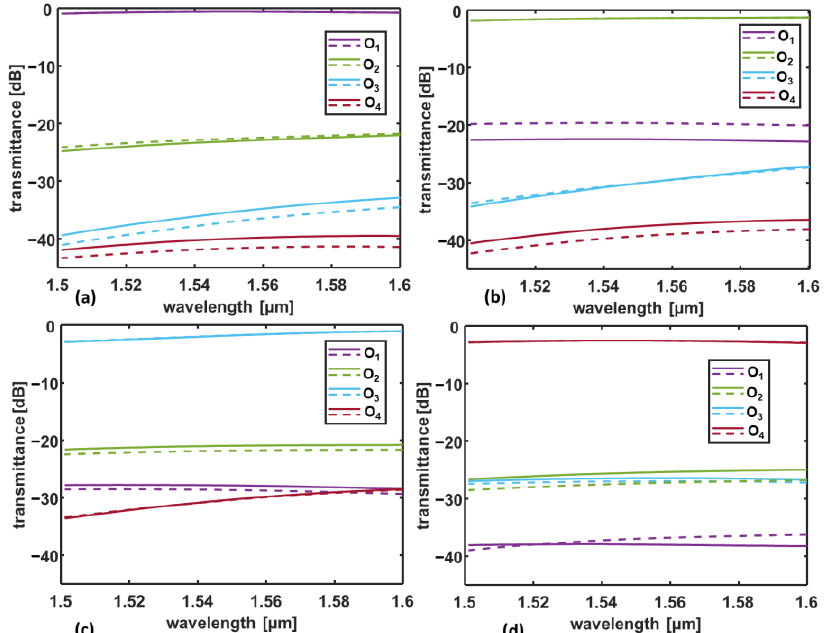
Figure 10. Transmittance in dB, calculated as a function of the wavelength, at the receiving OPAs, i.e., O 1 , O 2 , O 3 , and O 4 , when the transmitting OPA I 1 is excited with uniform (solid curves) and non-uniform (dashed curves) input signals. The phase shift values are: ( a ) α = 0°, ( b ) α = 51.4°, ( c ) α = 102.8°, and ( d ) α = 154.2°. The simulated device exploits reconfigurable OPAs made of N = seven taper antennas with a taper length L T = 2 μm. The link distance is d link = 70 μm, and the UV26 cladding thickness is t = 1 μm.